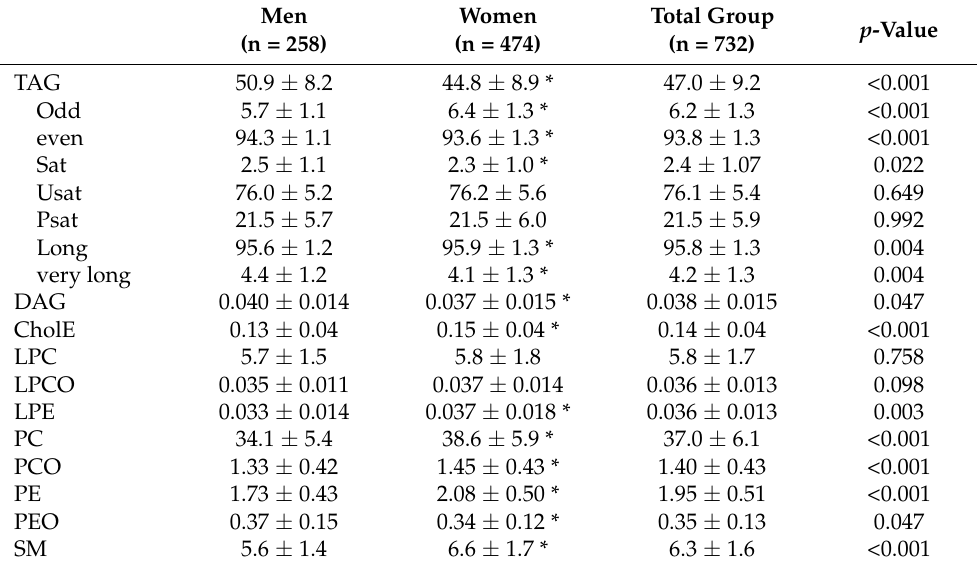
Table 2. Relative abundance individual lipid groups at baseline